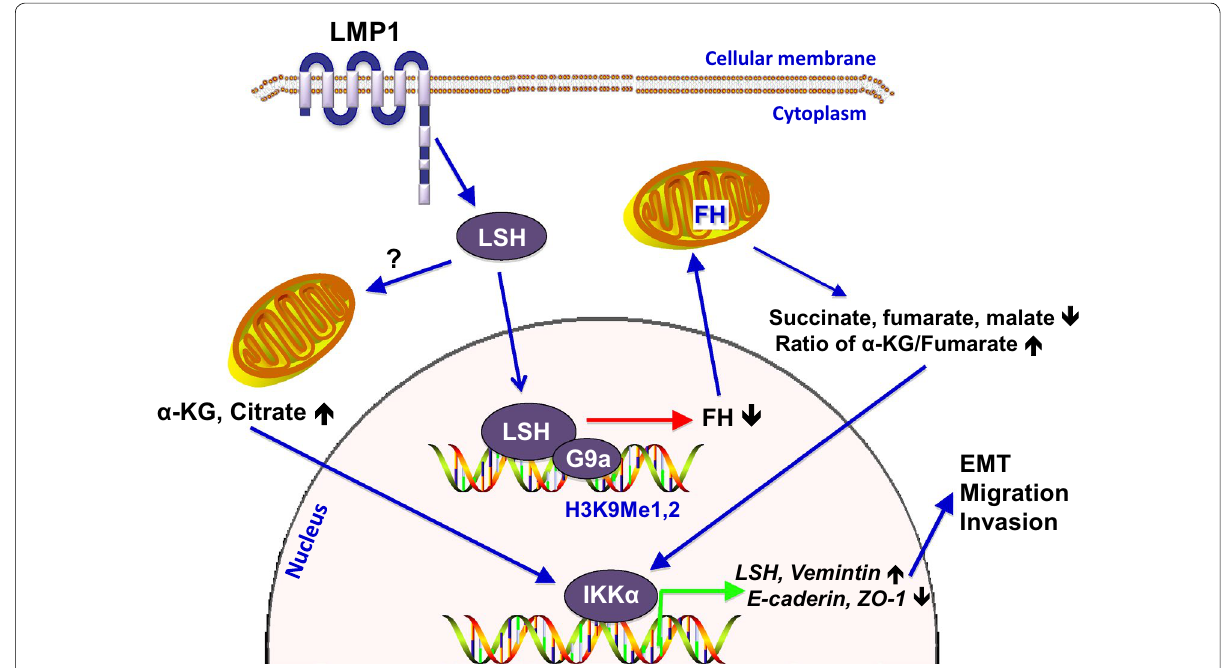
Fig. 1 Schematic model of lymphocyte‑specific helicase (LSH) in cancer progression. LSH promotes cell growth, migration, and invasion, which are characteristics of cancer progression. The effect of LSH is, in part, mediated by fumarate hydratase (FH), through the intact combination of LSH and euchromatic histone‑lysine N‑methyltransferase 2 (G9a). FH repression, in turn, leads to changes of tricarboxylic acid cycle (TCA) intermediates, including succinate, fumarate, and malate, and an increase in the ratio of α‑ketoglutarate (α‑KG) to fumarate. TCA intermediates promote migra‑ tion, invasion, and epithelial‑mesenchymal transition (EMT) through the decrease of E‑cadherin and tight junction protein ZO‑1 and the increase of vimentin. The changes of E‑cadherin and ZO‑1 are mediated by inhibitor of nuclear factor kappa‑B kinase alpha (IKKα), which directly binds to these